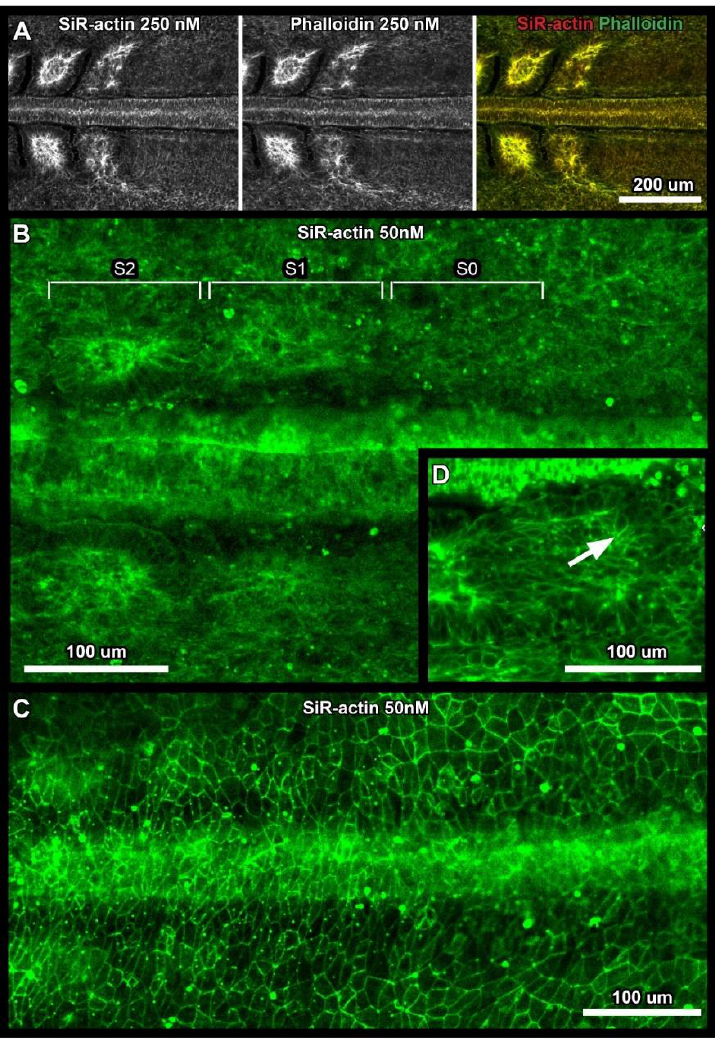
Figure 3. Confocal SiR-actin imaging in fixated samples and in vivo. Representative micrographs, acquired using an inverted spinning disc confocal microscope ( A ) or an upright confocal microscope ( B – D ). Anterior is always to the left, ventral view. ( A ) Co-staining of fixated chicken embryos with 250 nM SiR-actin and Alexa-555 conjugated phalloidin showing an almost perfect overlap in stain- ing. ( B ) Overview of segmenting paraxial mesoderm on both sides of the neural tube, in vivo stain- ing with 50 nM SiR-actin. Somite numbers of newly forming somites are indicated according to [27]. ( C ) F-Actin cortices of endodermal cells, in vivo staining. ( D ) High resolution micrograph of live embryo. Formation of the apical actin cortex in somite S1 is more progressed in the posterior half of the somite (white arrow). Image capture settings: ( B – D ) Images were acquired using an upright confocal microscope (Leica SP5, Leica Microsystems B.V., Amsterdam (NL)), either using a 10× air objectives (NA = 0.40) or a 63× water immersion objective (NA = 0.90). Due to the short working distance of the objective, images were acquired without a layer mineral oil on top of the medium.